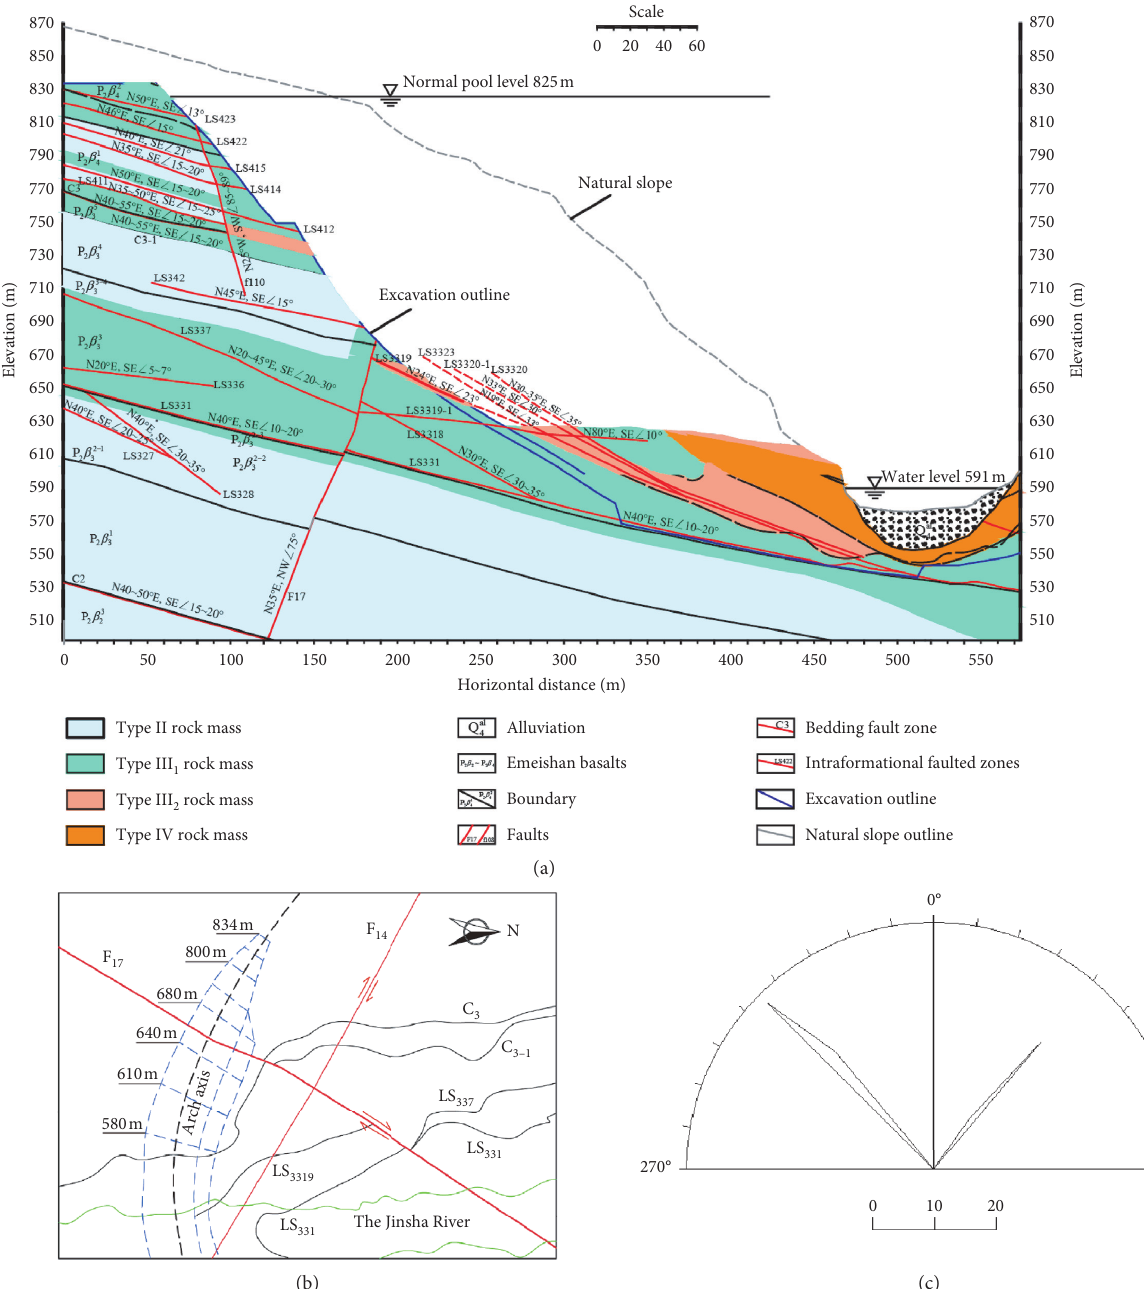
Figure 3: Arch axis geological section of the left bank slope, (a) geological engineering plane figure of left bank slope, (b) and the strike rose diagram of dominant joints (c)